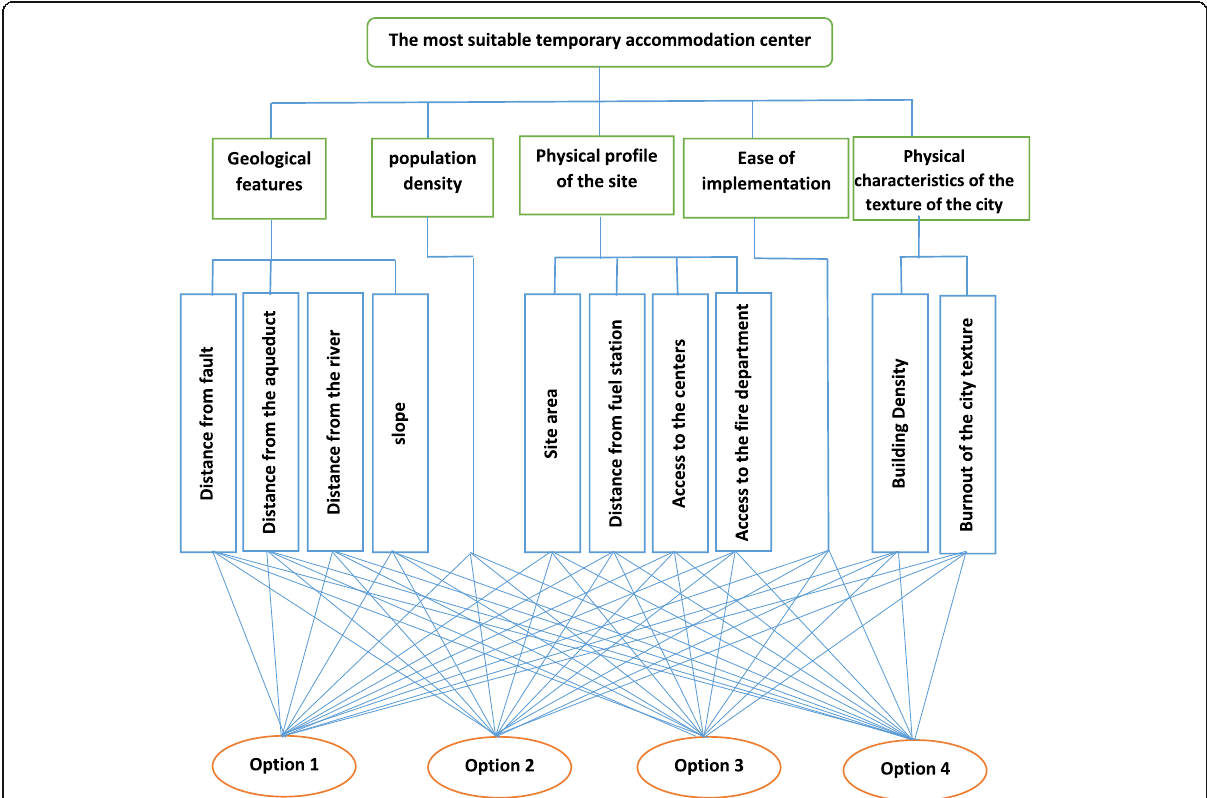
Fig. 13 Hierarchical structure of locating temporary accommodation